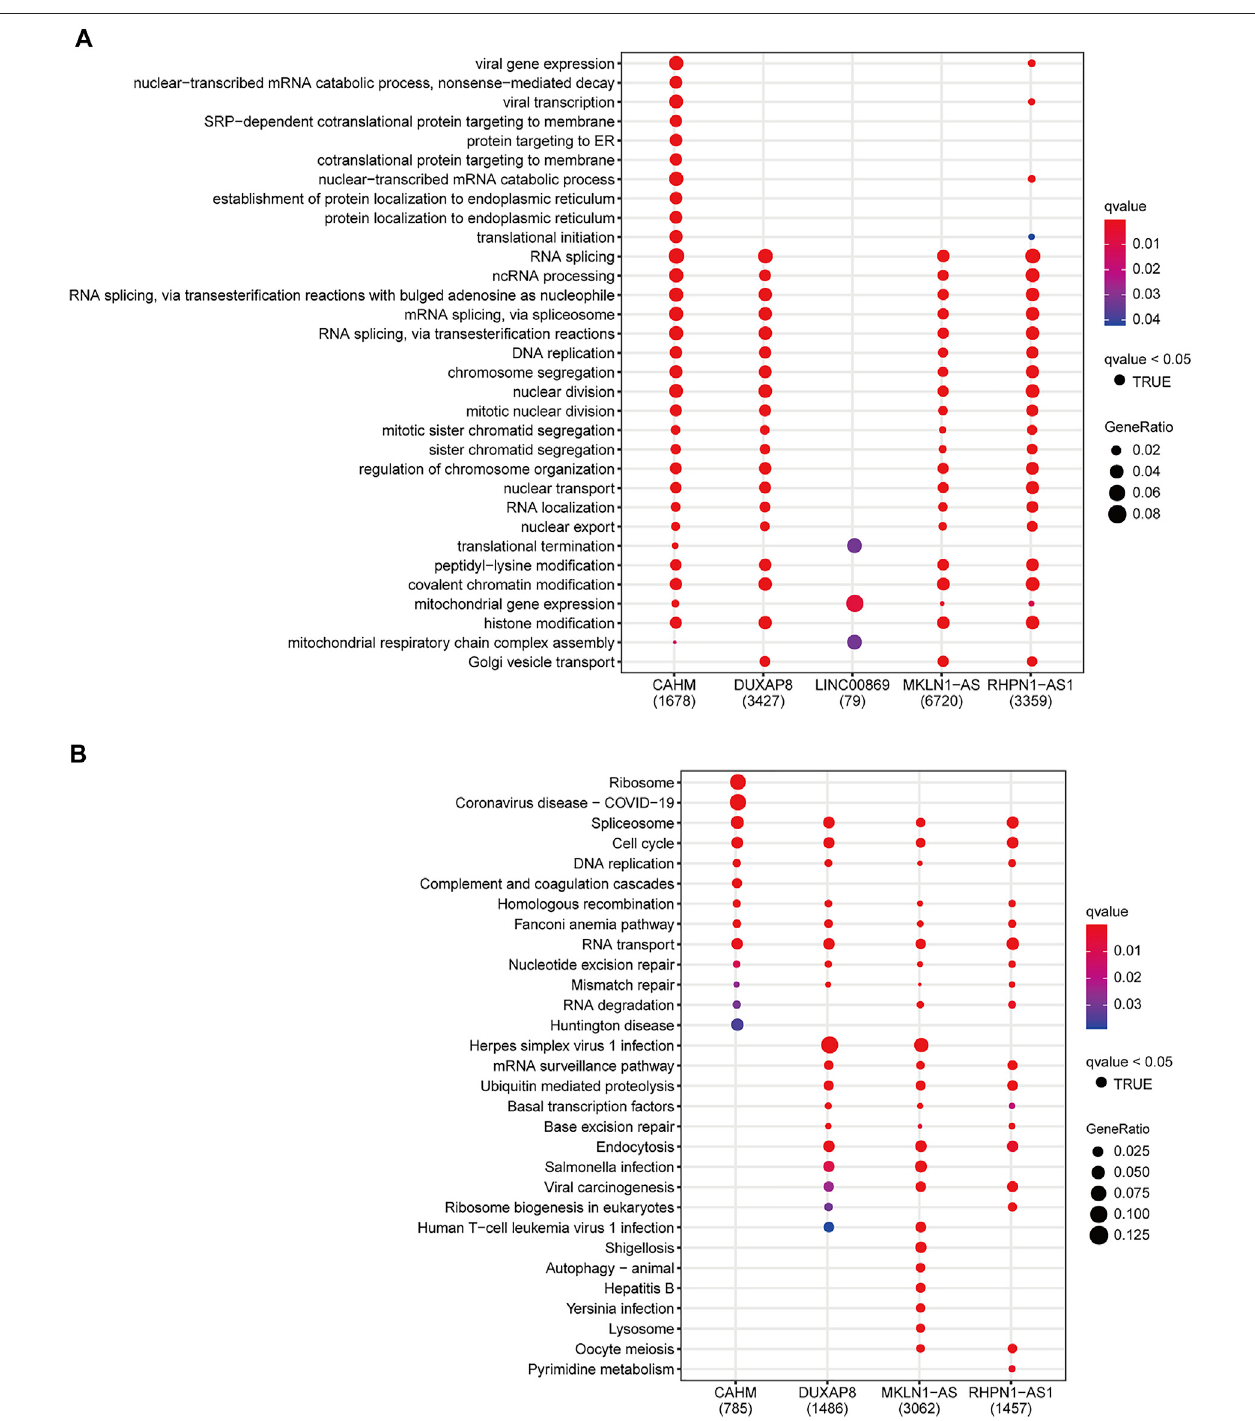
FIGURE9| FunctionalannotationofCAHM,DUXAP8,LINC00869,MKLN1-AS, and RHPN1-AS1. Signi fi cantlyenriched termsintheGObiological processterms (A) and KEGG pathway (B) , according to the corresponding coexpression genes of the above fi ve key lncRNAs. GO: Gene Ontology. KEGG: Kyoto Encyclopedia of Genes and